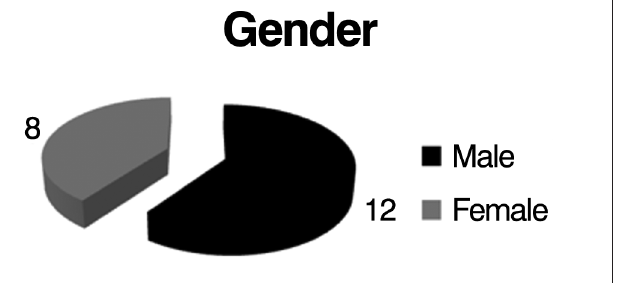
Figure 1. Distribution by gender.